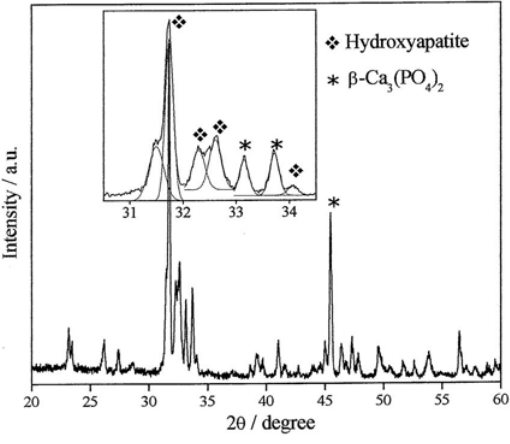
Fig. 6 – Powder XRD patterns of the hydroxyapatite inorganic